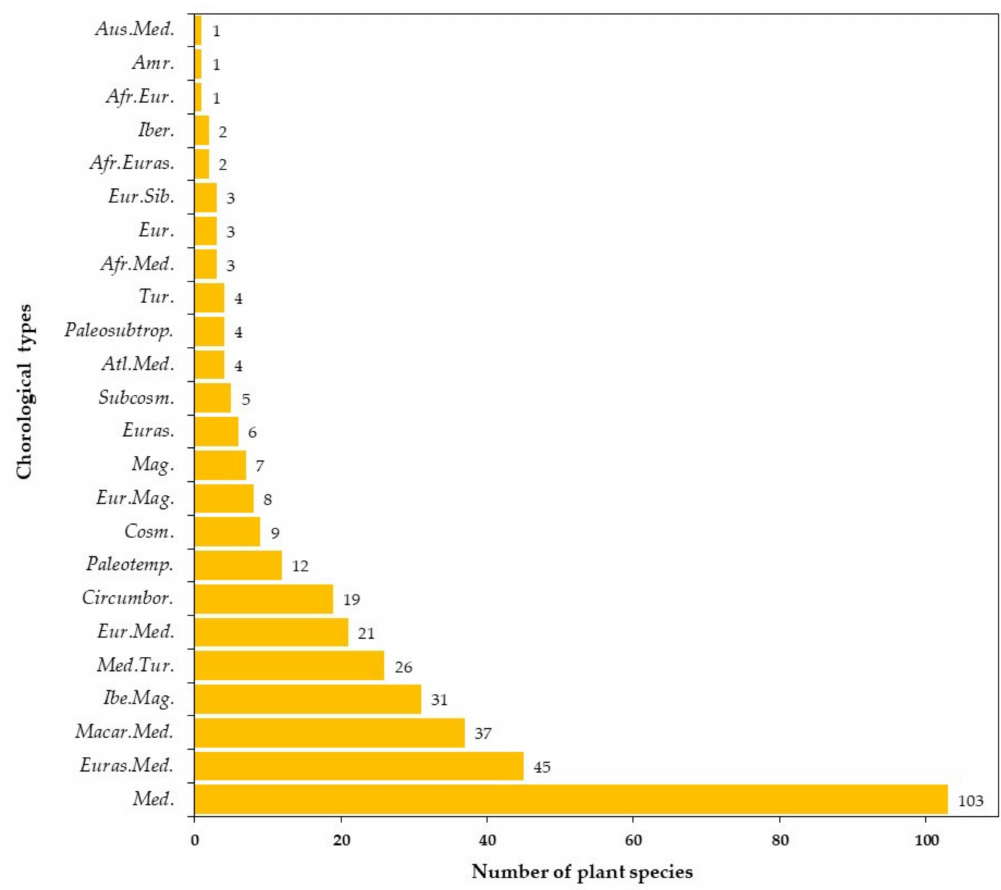
Figure 5. Chorotype spectrum of the recorded plant species in the studied forest rangelands of Northern Morocco. Afr: African, Amr: American, Asi: Asian, Atl: Atlantic, Aus: Australian, Cau: Caucasian, Circumbor: Circumboreal, Cosm: Cosmopolitan, Eur: European, Euras: Eurasian, Iber: Iberian, Ira: Iranian, Macar: Macaronesian Mag: Maghrebian, Med: Mediterranean, Paleosubtrop: Pa- leosubtropical, Paleotemp: Paleotemporal, Sib: Siberian, Subcosm: Subcosmopolitan, Tur: